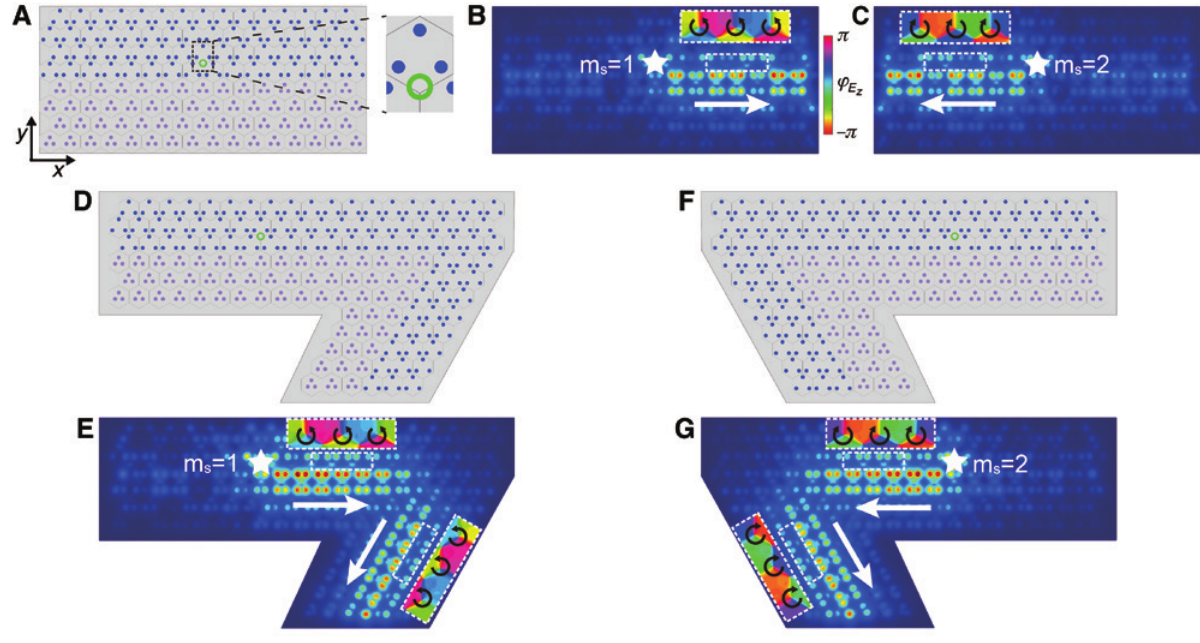
Figure 4: Excitation of unidirectional edge states at the frequency of 4.36 GHz. (A) Schematic of the straight edge in the x - y plane. The magnified region in the right side shows the position of the source. (B) Rightward and (C) leftward unidirectional edge states excited by the source with m white arrow indicates the direction of the energy flow. The inset shows the The black arrows denote the direction of the phase gradient. Schematic of a 120 ° sharp bend edge with the bend in the (D) right and (F) left sides of the source. (E) Rightward and (G) leftward unidirectional edge states excited by the source with m